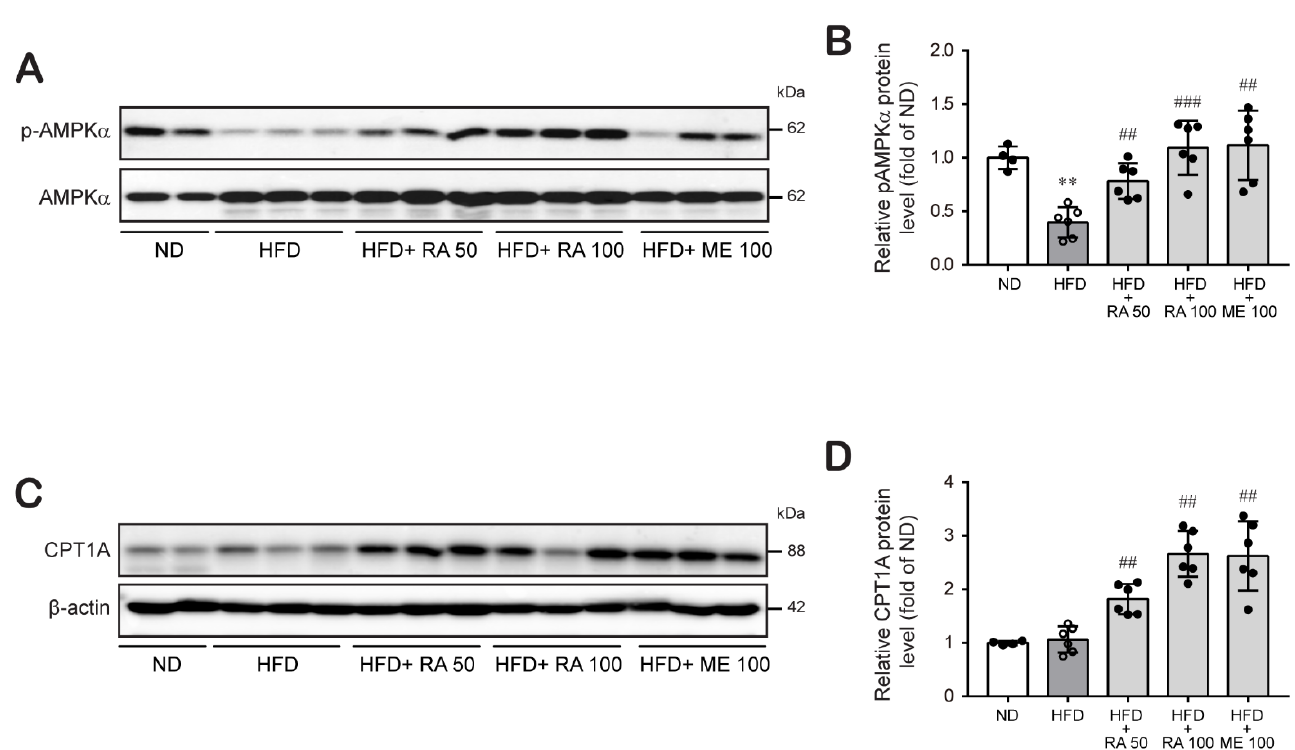
Figure 5. RA enhances fatty acid β -oxidation by activating the AMPK-CPT1A pathway in HFD-fed mice. ( A – D ) Liver tissues were lysed to perform western blot analysis to determine the protein levels of phospho-AMPK α , AMPK α ( A , B ), and CPT1A ( C , D ). Data are presented as the mean ± SD ( n = 4–6) ( B ). ** p < 0.01 vs. ND control mice; ## p < 0.01, ### p < 0.001 vs. HFD mice vs. RA 50.